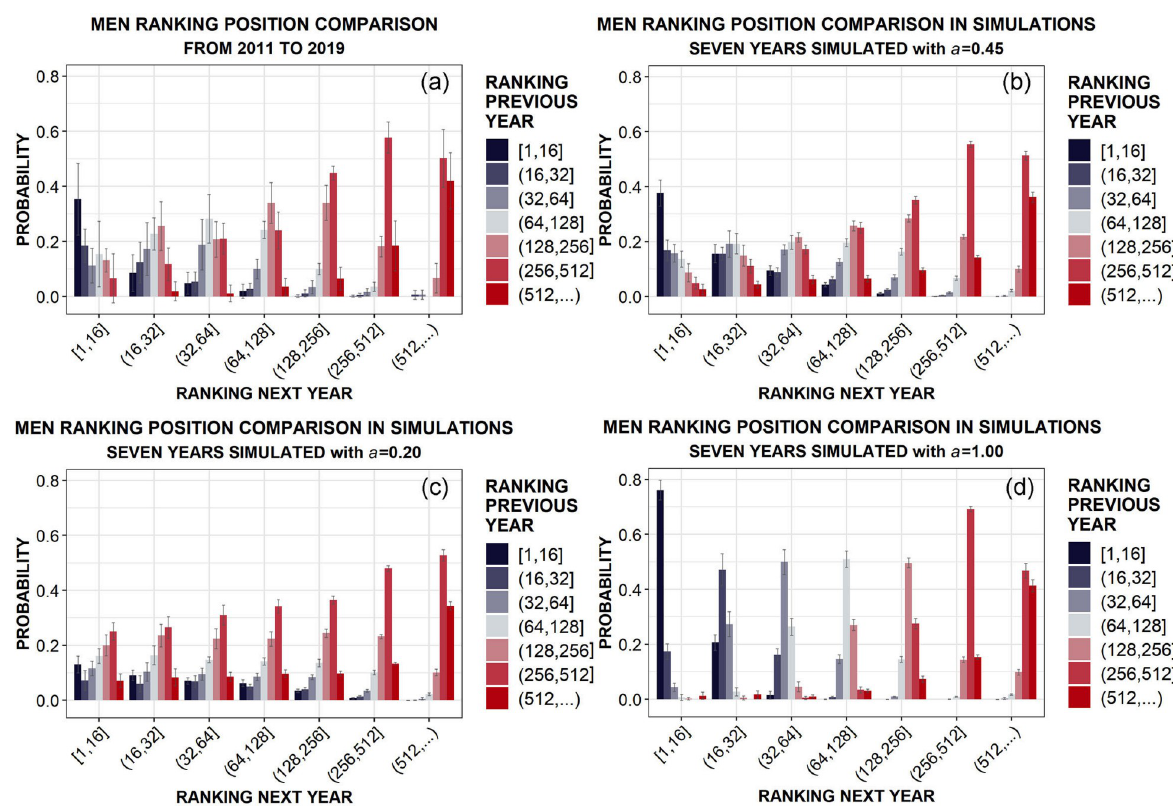
Fig 3. Comparison between data and simulations (averaged over 10 runs). Probability of having the same or a different placement the following year in Junior Men, given the associated ranking placement in the previous year. Ranking positions are arranged in groups of different sizes, to enhance visualization. Sketch of the panels: (a) data; (b) simulation with the optimal value of a ; (c) simulation with a very low value of a ; (d) simulation with the highest possible value of a . For each mean outcome, the corresponding standard deviation is also reported as an error bar.